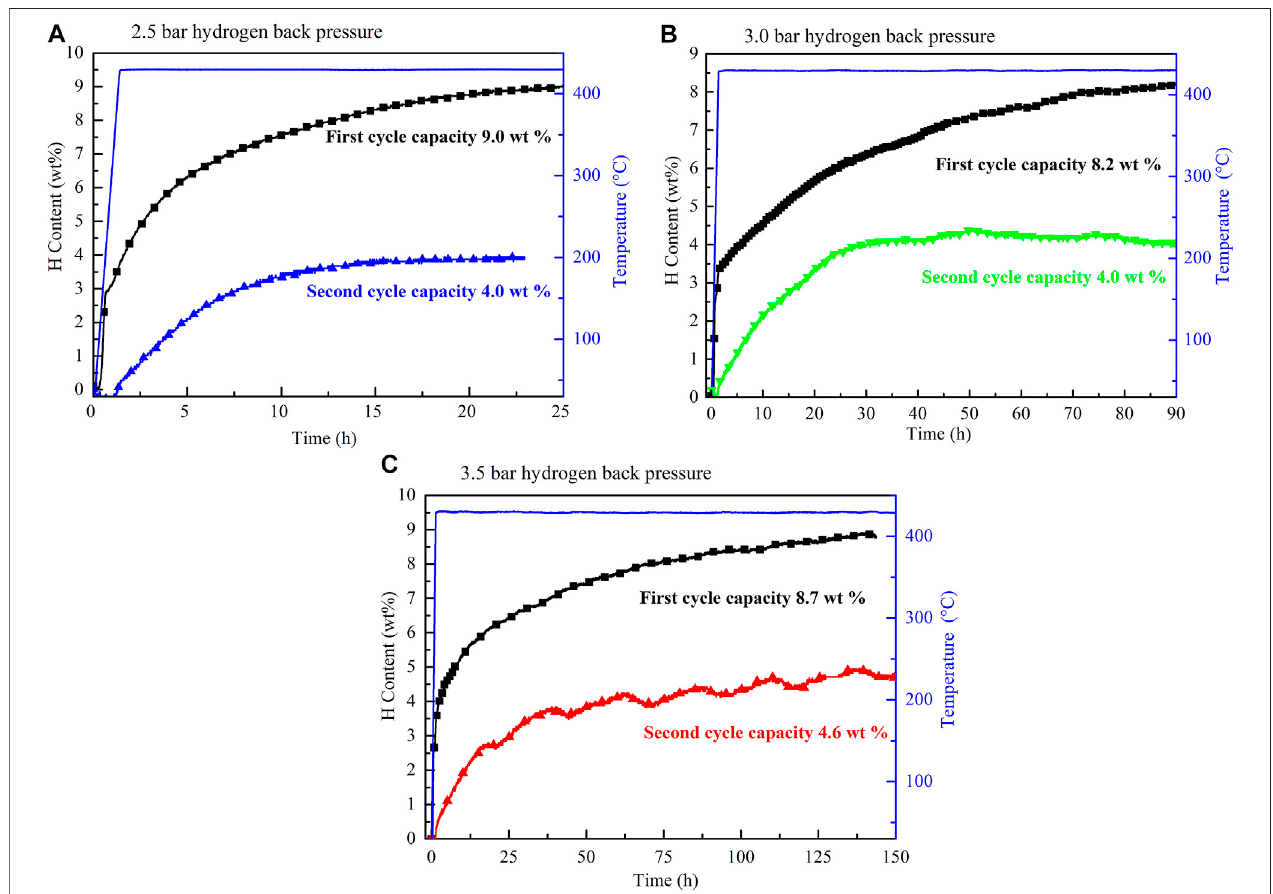
FIGURE8| Cyclicdehydrogenation curvesoftheTiF 3 -added 2LiBH 4 – Li 3 AlH 6 composites with (A) 2.5 bar, (B) 3.0bar,and (C) 3.5bar ofhydrogen back pressure in the fi rst and second dehydrogenation cycles.